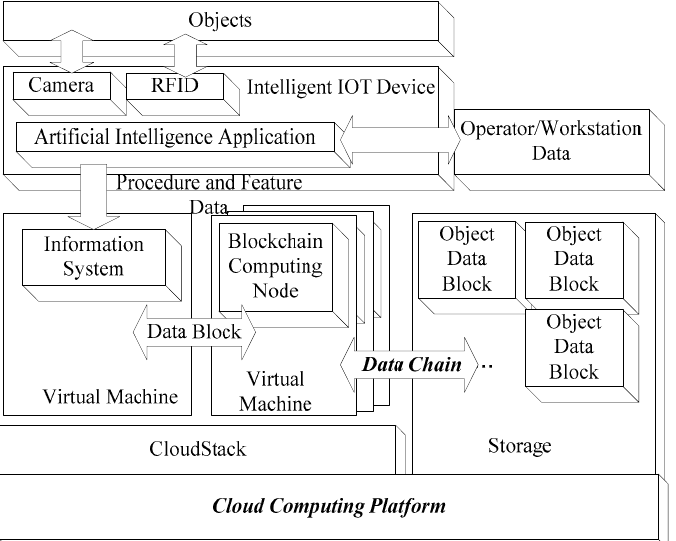
Figure 1. Structure of the proposed intelligent Internet of Things (IoT) device with a cloud computing platform for smart manufacturing.